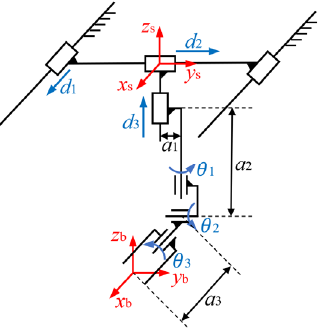
Figure 1. Schematic diagram of mechanism.